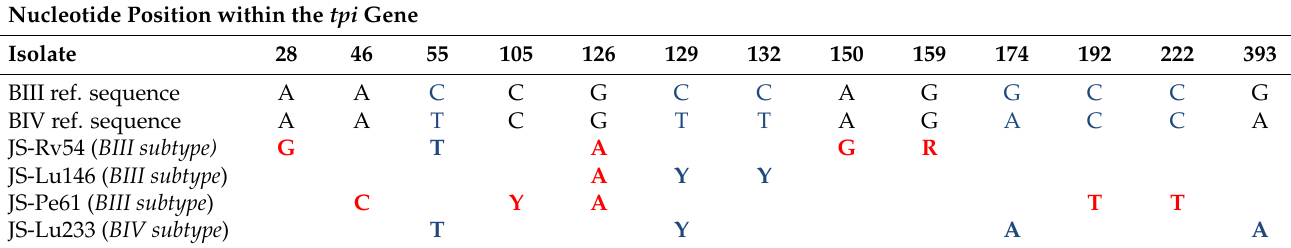
Table 4. Nucleotide polymorphism in B assemblages of G. duodenalis in the partial tpi